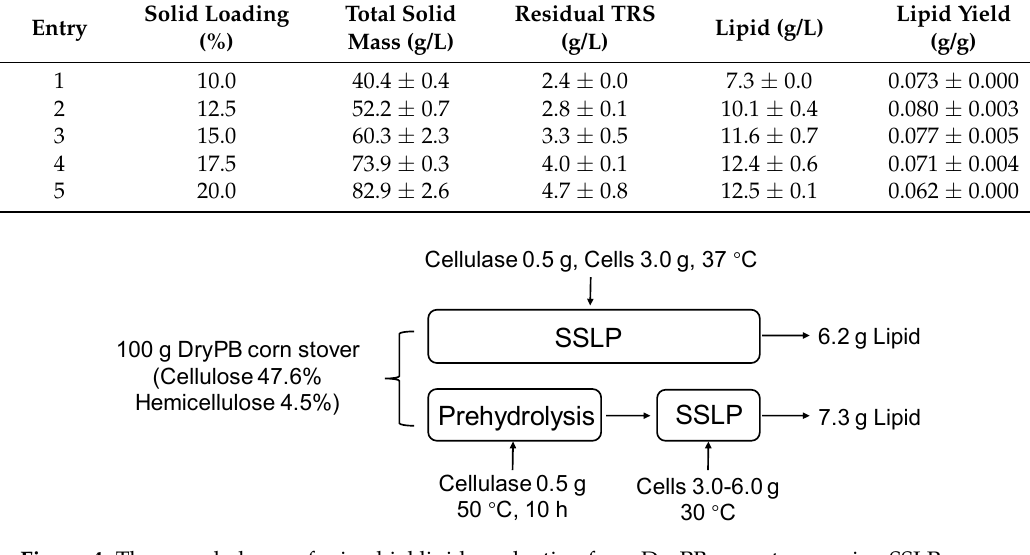
Figure 4. The mass balance of microbial lipid production from DryPB corn stover using SSLP process and PreSSLP process. Table 4. Lipid production from corn stover by different